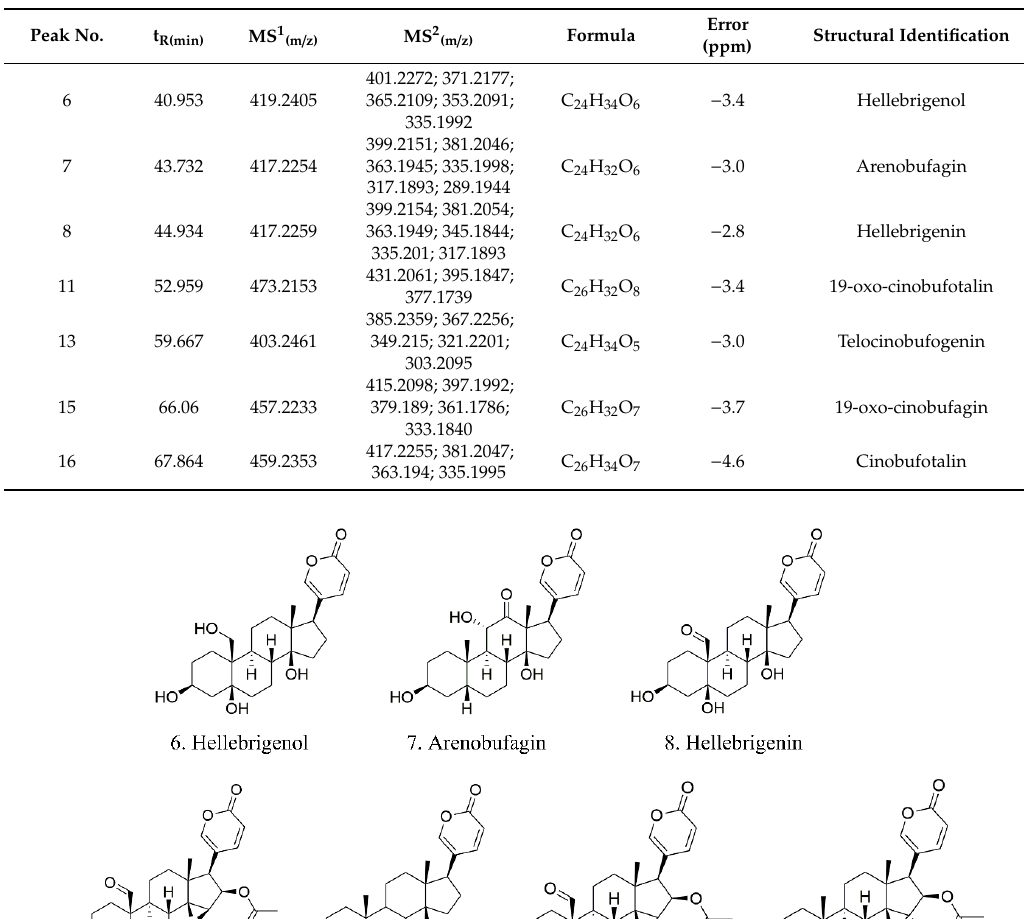
Table 8. MS data of 7 predicted active compounds (peaks) in toad venom.